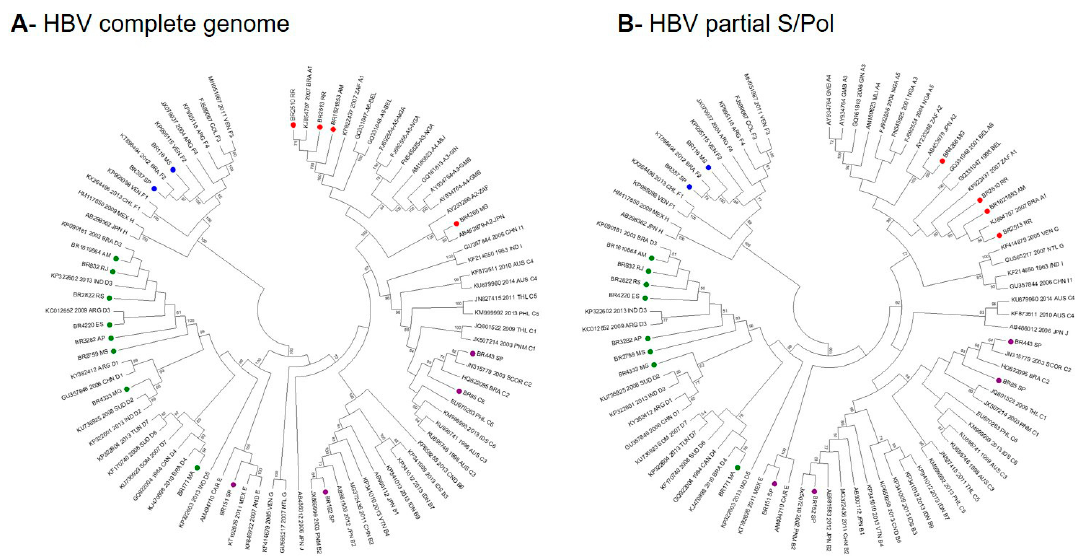
Figure 1. Comparison of the full-length and partial S/pol phylogenetic trees topologies. Red dots: HBV/A; purple dots: HBV/B, C and E; green dots: HBV/D; blue dots: HBV/F genotypes/subgenotypes.